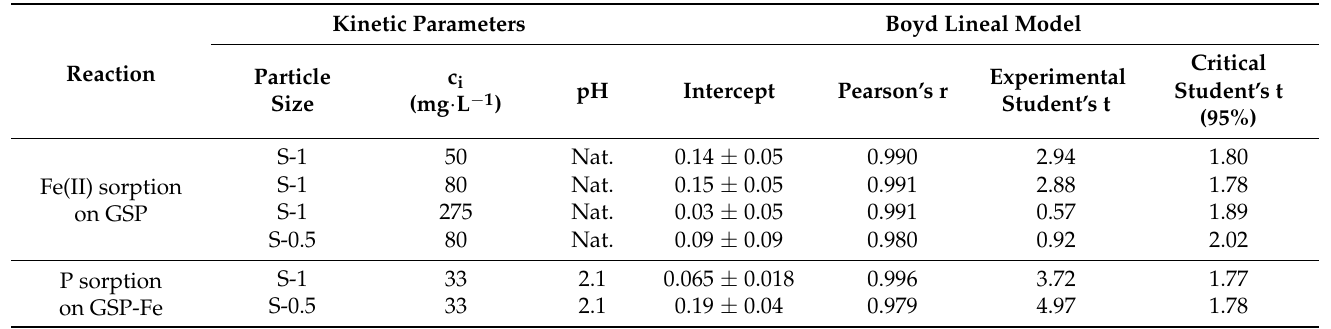
Table 2. Kinetic parameters obtained using the Boyd diffusion model for Fe and P